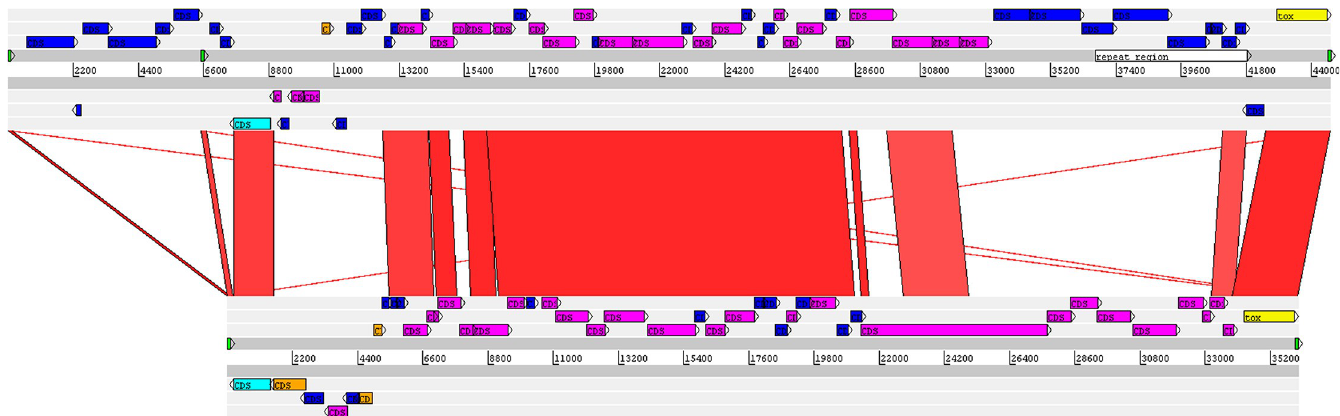
Fig 5. Alignment of tox + prophages form Corynebacterium silvaticum PO100/5 and C . ulcerans 0102. The red lines connect sequences with at least 75% identity. Light blue–Phage integrase; Orange–Phage-related transcriptional regulator; Pink–Phage-related coding sequence (CDS); Yellow–Diphtheria toxin CDS; Dark blue– other CDS; Green–tRNA.